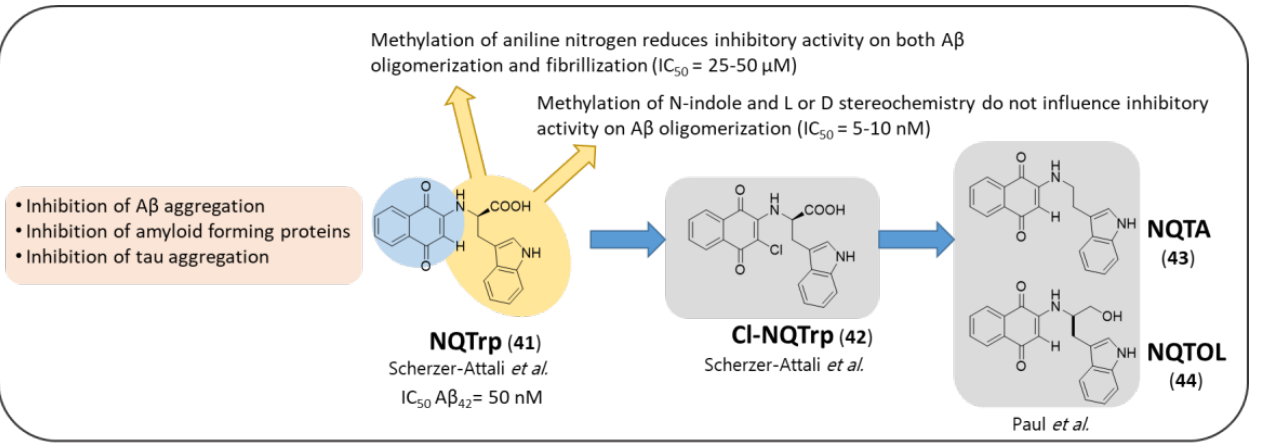
Figure 10. NQ-tryptophan (NQTrp) hybrids against AD.